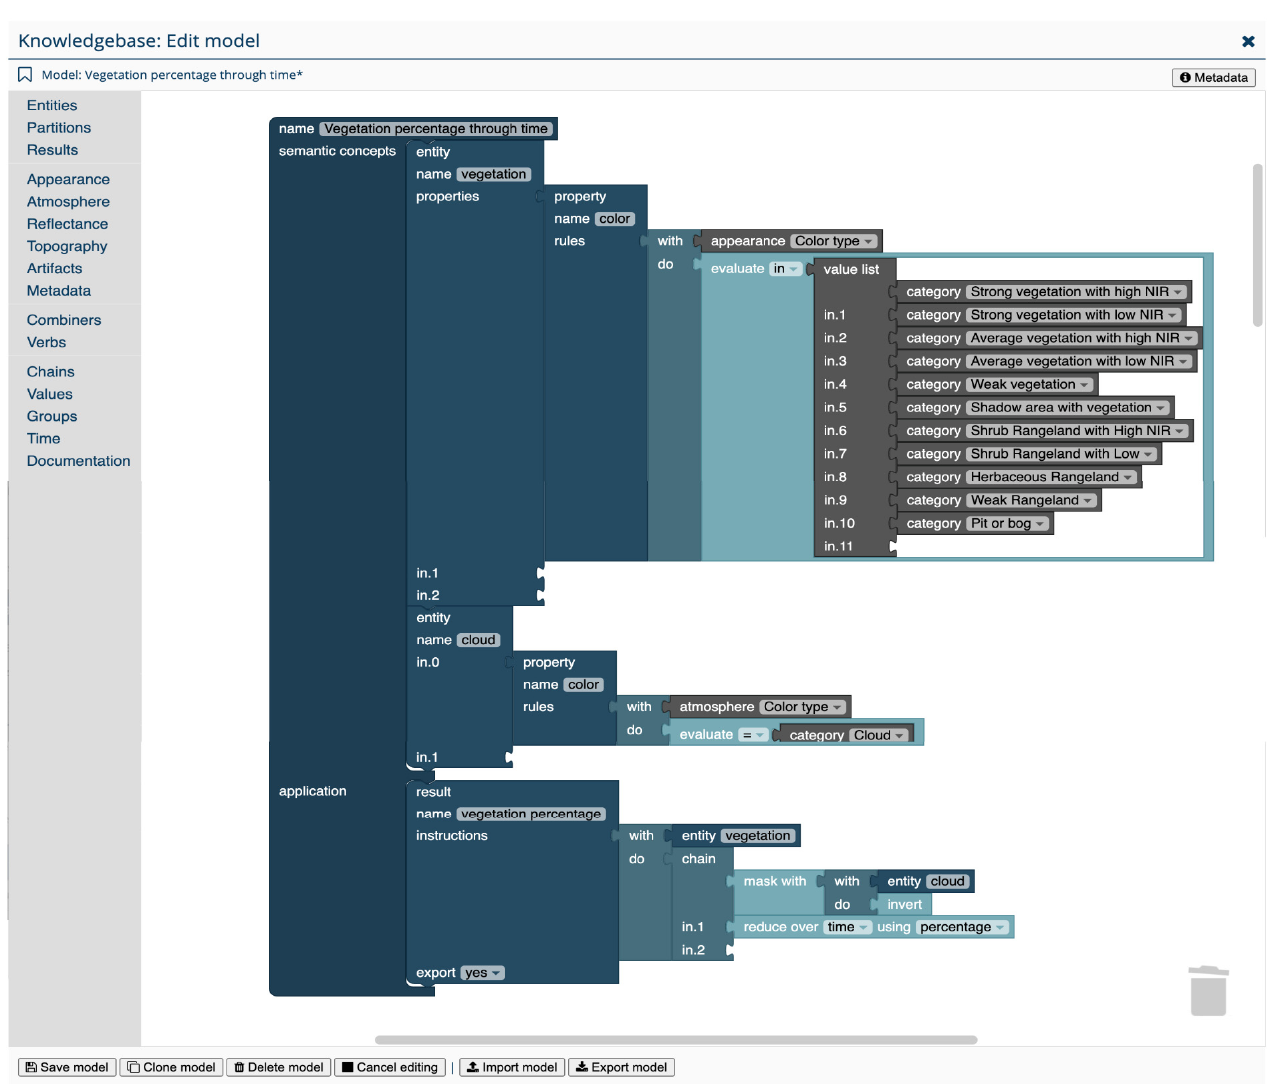
Figure 3. Graphical knowledge engineering approach implemented in our model editor (screenshot). The model editor is based on the Blockly library with our custom blocks for semantic querying. The figure shows the definition of two entities (vegetation and cloud) as semantic concepts based on the properties of combined spectral categories and their analysis through time, which is defined as result in the application part (cloud masked ratio of observed vegetation in any user defined time span and AOI). The semantic model does not require using custom, arbitrary thresholds or image-specific descriptors.